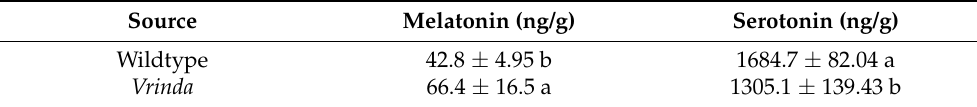
Table 2. Average concentrations of melatonin (ng/g) and serotonin (ng/g) in in vitro grown leaf tissues of the selected line Vrinda and a representative wildtype line with three biological replications. Columns with different letter indicate significant difference between two lines (Tukey’s test, p < 0.05).